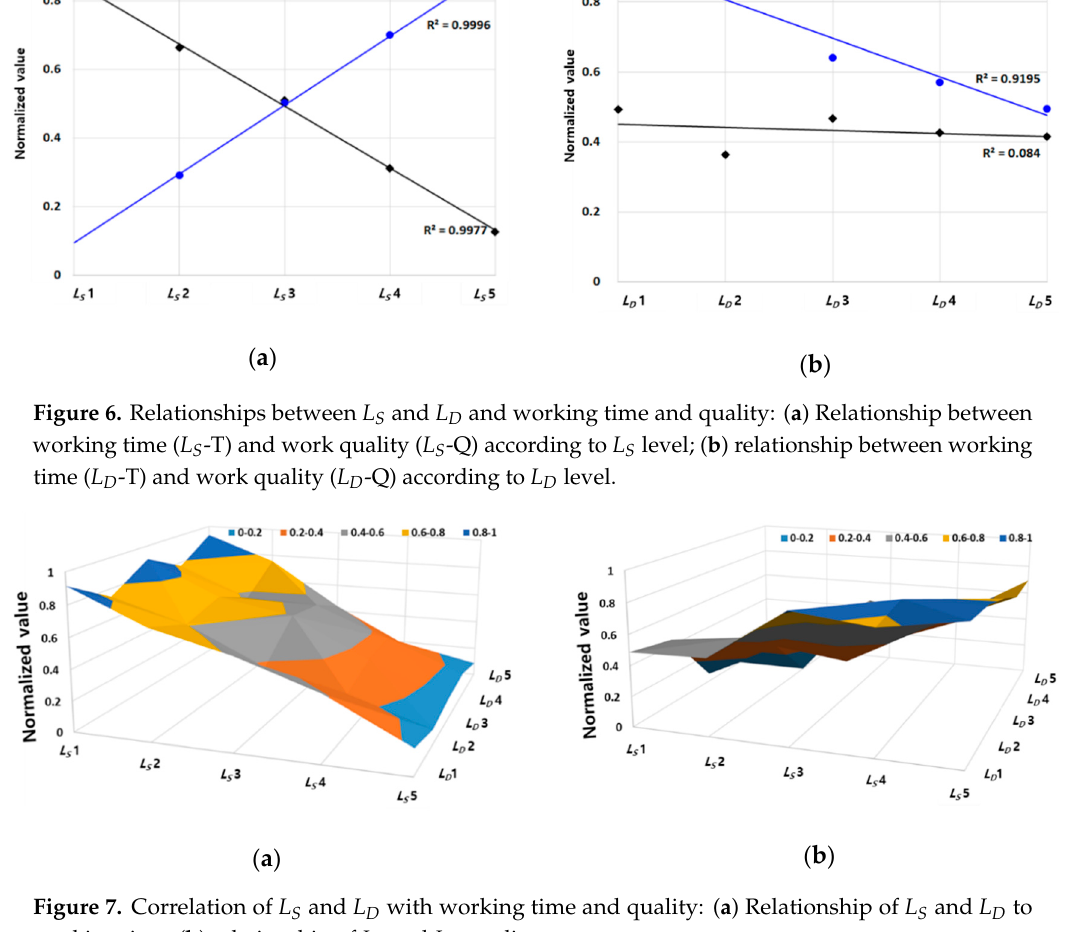
Figure 7. Correlation of L S and L D with working time and quality: ( a ) Relationship of L S and L D to working time; ( b ) relationship of L S and L D quality.